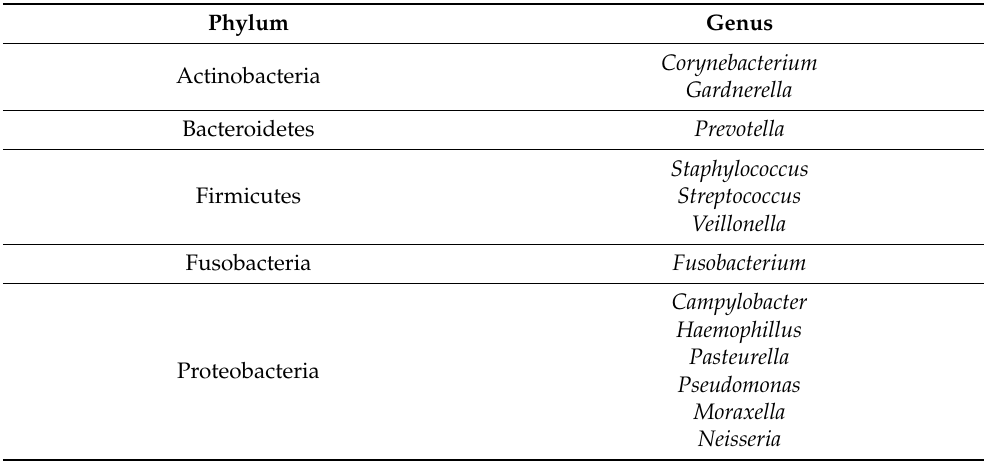
Table 2. Taxonomy of the most common phyla and genera described in the human lung micro- biome